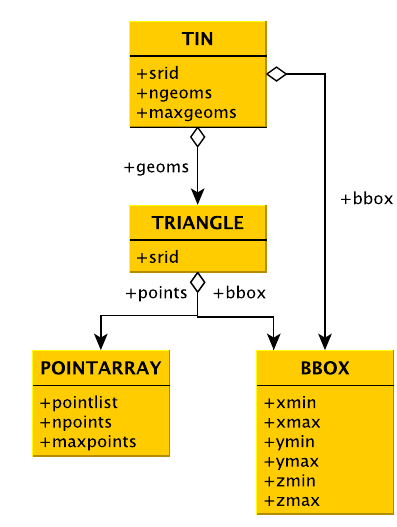
Table 1: Existing TIN data structures